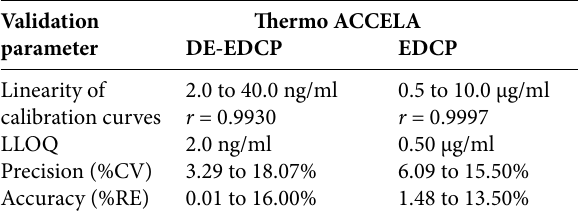
Table 3: Validation parameters for the DE-EDCP and EDCP in an aqueous buffer, without a biological matrix (Thermo ACCELA) Validation